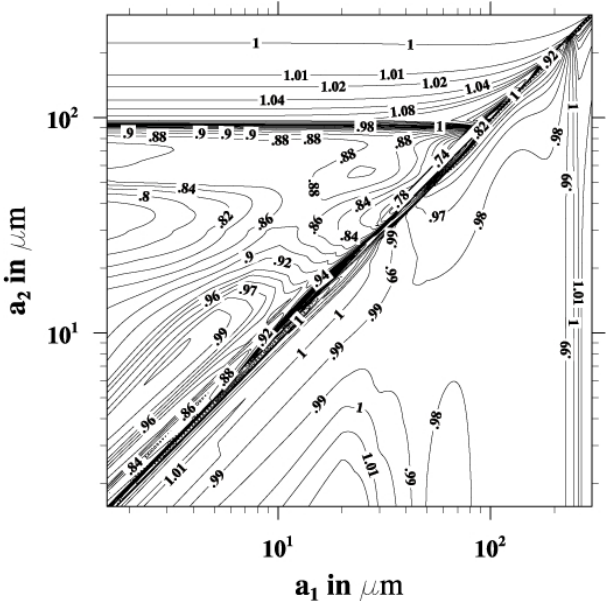
Fig. 1. Contour lines of the ratio R for (cid:15) 2 = 50cm 2 s − 3 (lower right) and (cid:15) 2 = 500cm 2 s − 3 (upper left), with l 2 /l 1 = 50 and l 1 = 0 . 5m. Since R (a 1 ,a 2 ) = R (a 2 ,a 1 ) , therefore, only half of the do- main is shown for each (cid:15) 2 .